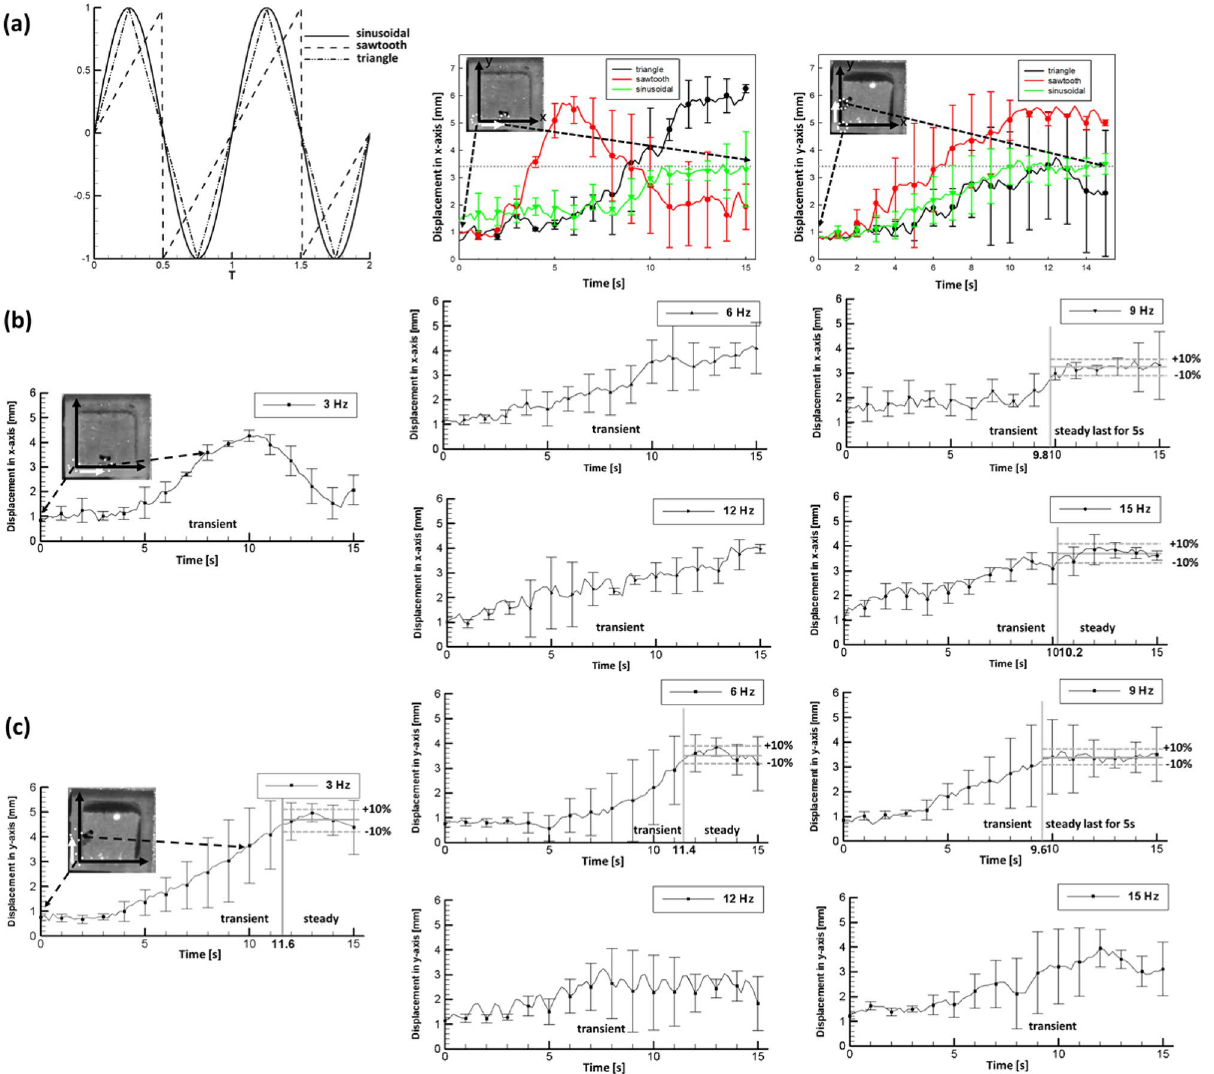
Figure 2. Performance of the microrobot under different control parameters. ( a ) Typical illustration of all the three waveforms, moving trajectories in x and y-direction of microrobot controlled by triangle (black curve), sawtooth (red curve), and sinusoidal (green curve) waveforms with 9 Hz of frequency respectively along with the microphotographs of the microrobot. ( b ) Moving trajectories in x-direction and ( c ) y-direction of the microrobot controlled by sinusoidal waveform with 3, 6, 9, 12, and 15 Hz of frequency. Error bars represent one standard deviation in either direction from three repeated